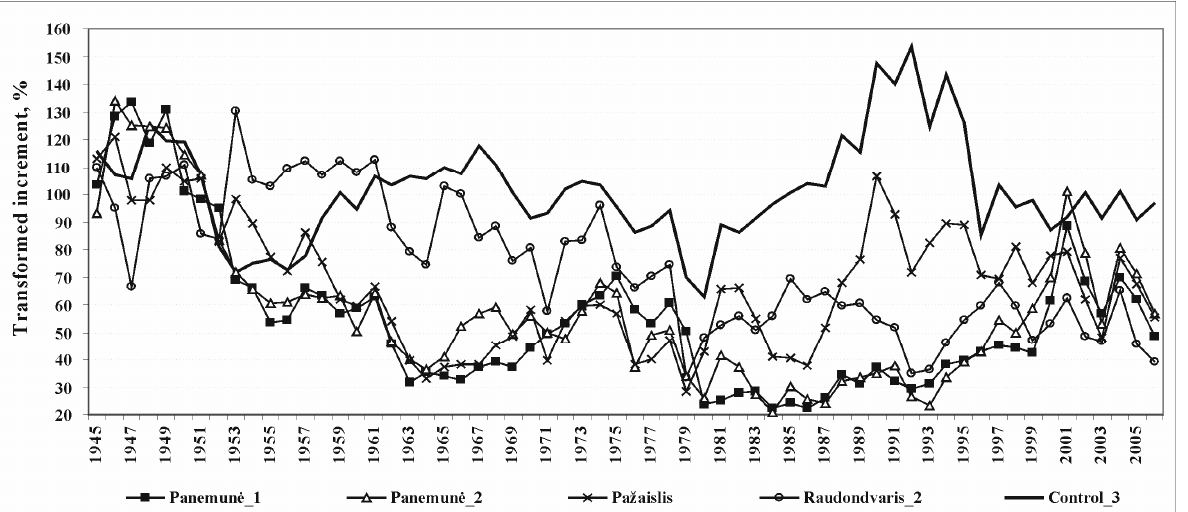
Fig. 6. Transformed dendroscales of 160 – 180 year old pines in Control_3 and Kaunas city sample plots